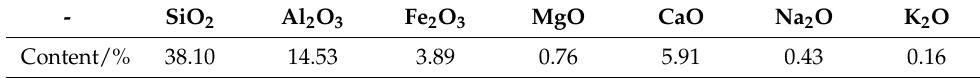
Table 3. Main chemical composition of tunneling coal gangue powder.